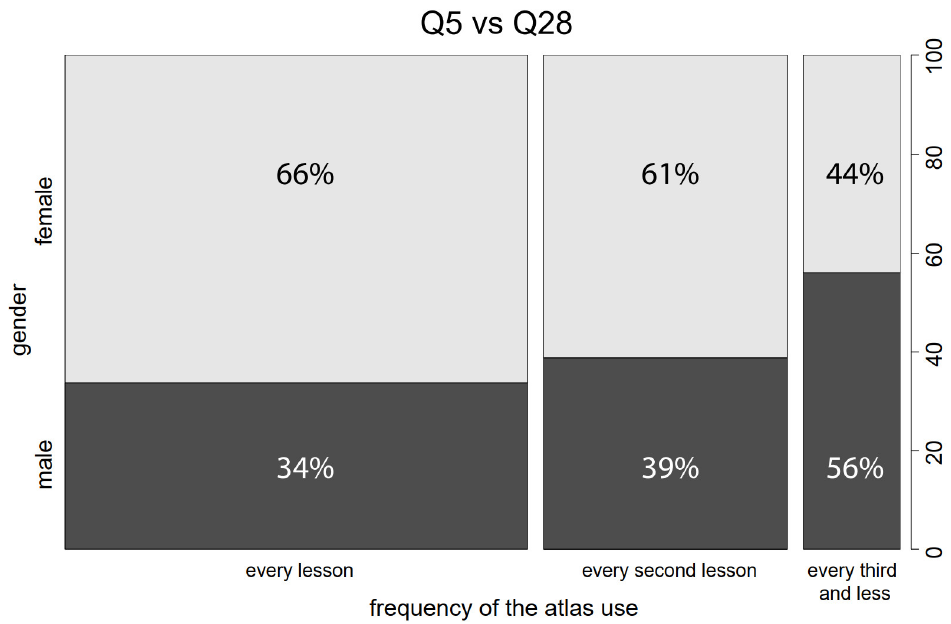
Figure 10. The relationship between Q28 (gender) and Q5 (frequency of atlas use).